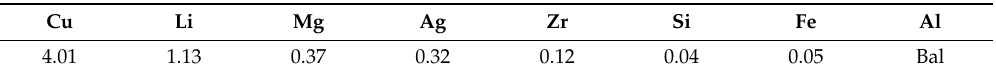
Table 1. Nominal composition (wt%) of the Al–Cu–Li alloy.